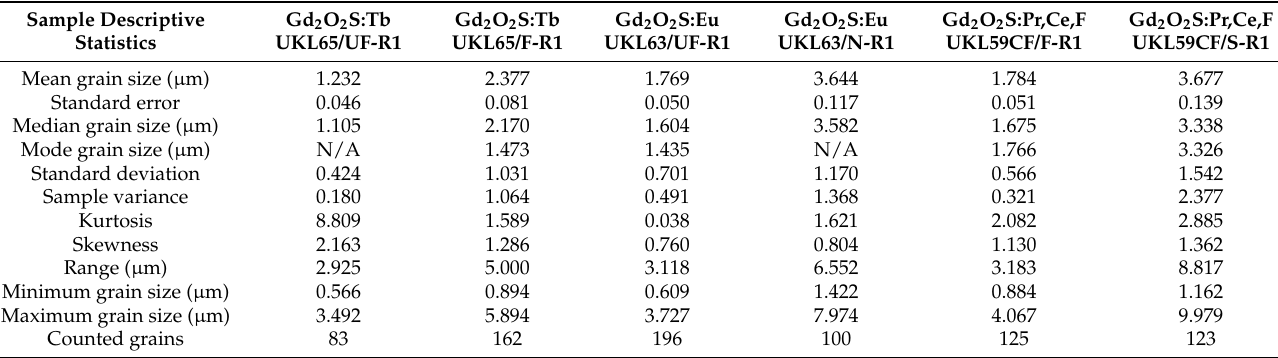
Table 2. Descriptive statistics for Gadolinium Oxysulphide phosphor